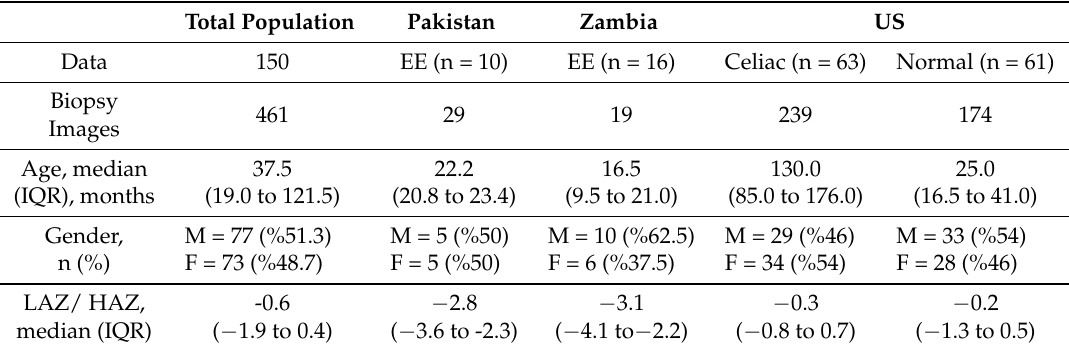
Table 1. Population results of biopsies